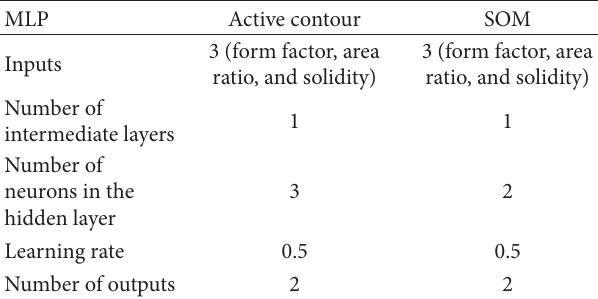
Table 4: Topological configuration of MLP.